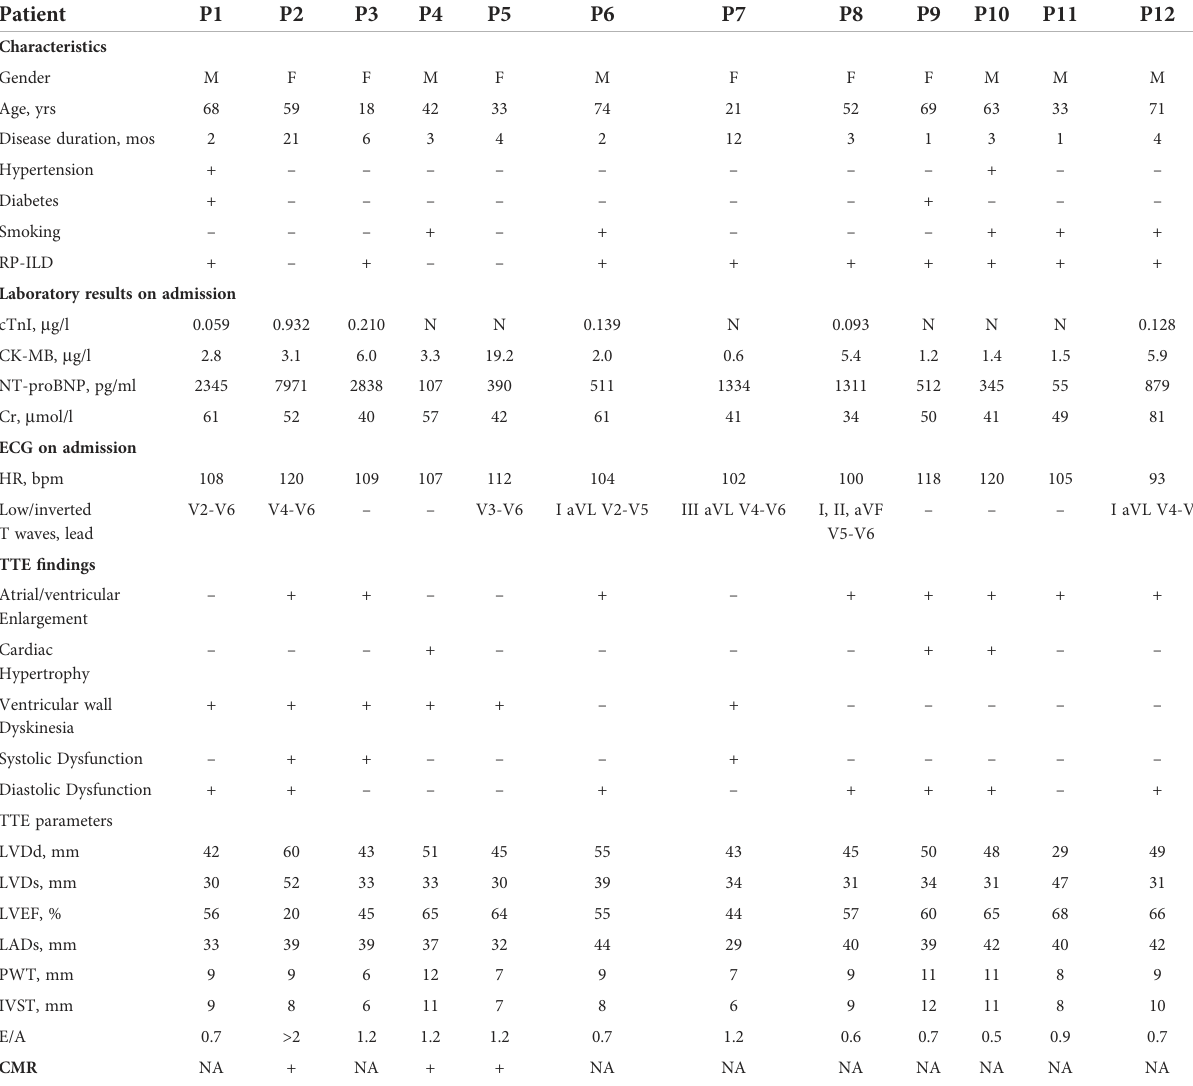
TABLE 1 Clinical features and cardiac examinations fi ndings of anti-MDA5 Ab+ DM/CADM patients with myocardial involvement. Patient P1 Characteristics